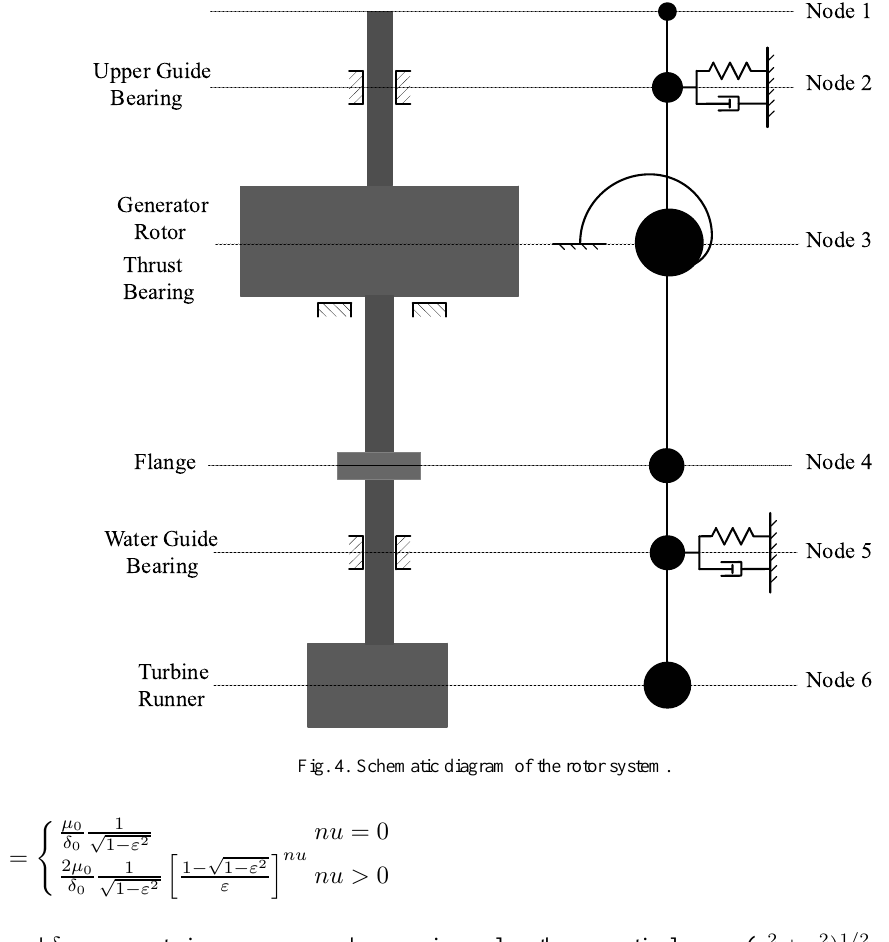
Fig. 4. Schematic diagram of the rotor